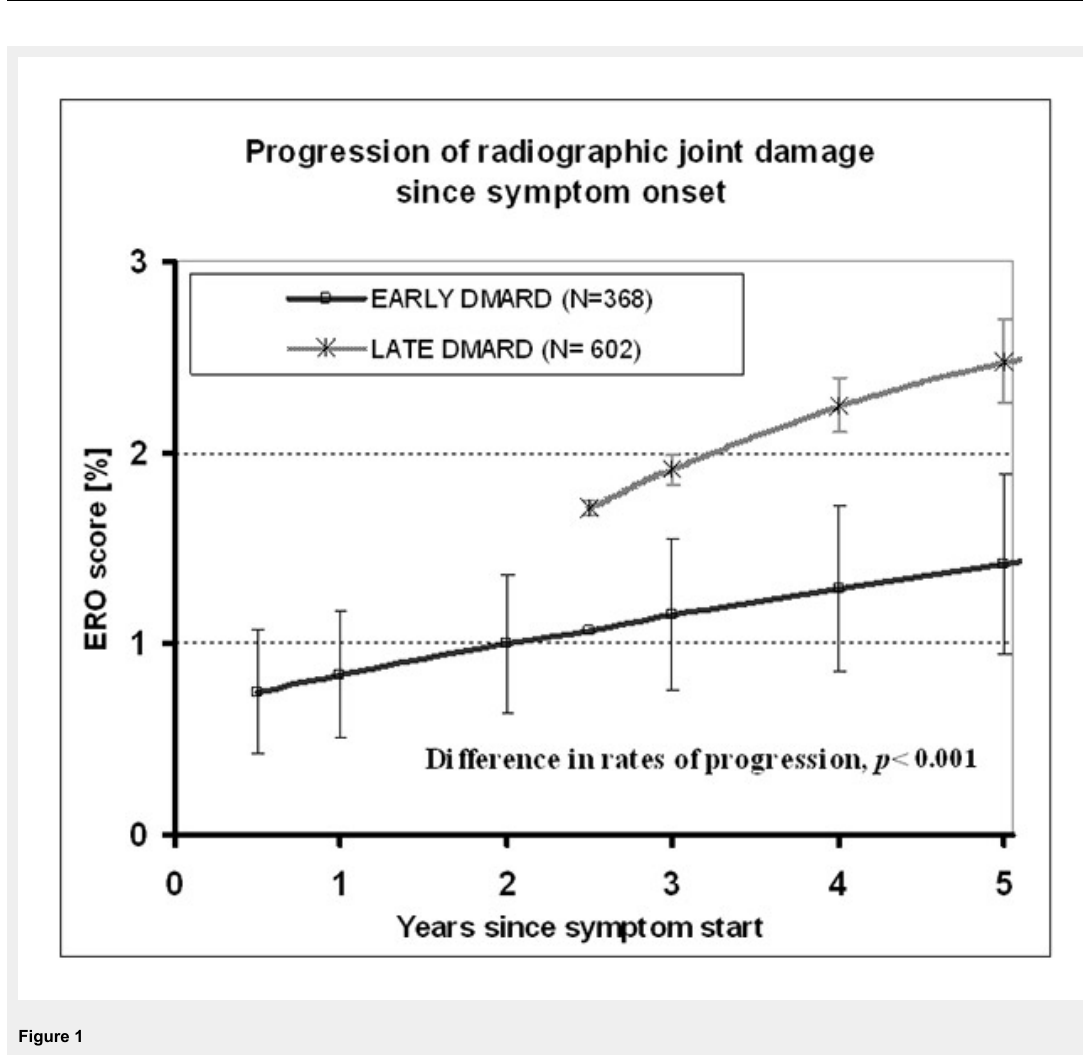
Progression of joint erosion score (Ratingen) over time in patients treated early vs patients treated late with disease-modifying antirheumatic drugs (DMARDs). Mean erosion (ERO) scores (± SEM) are shown as percentages of maximum damage score as a function of time since symptom onset. Regression analysis with adjustment for potential confounders of radiographic progression revealed a significant difference in the slopes of radiographic damage progression. Reproduced from: Kyburz D, Gabay C, Michel BA, Finckh A. The long-term impact of early treatment of rheumatoid arthritis on radiographic progression: a population-based cohort study. Rheumatology (Oxford). 2011;50(6):1106–10, by permission of the British Society of